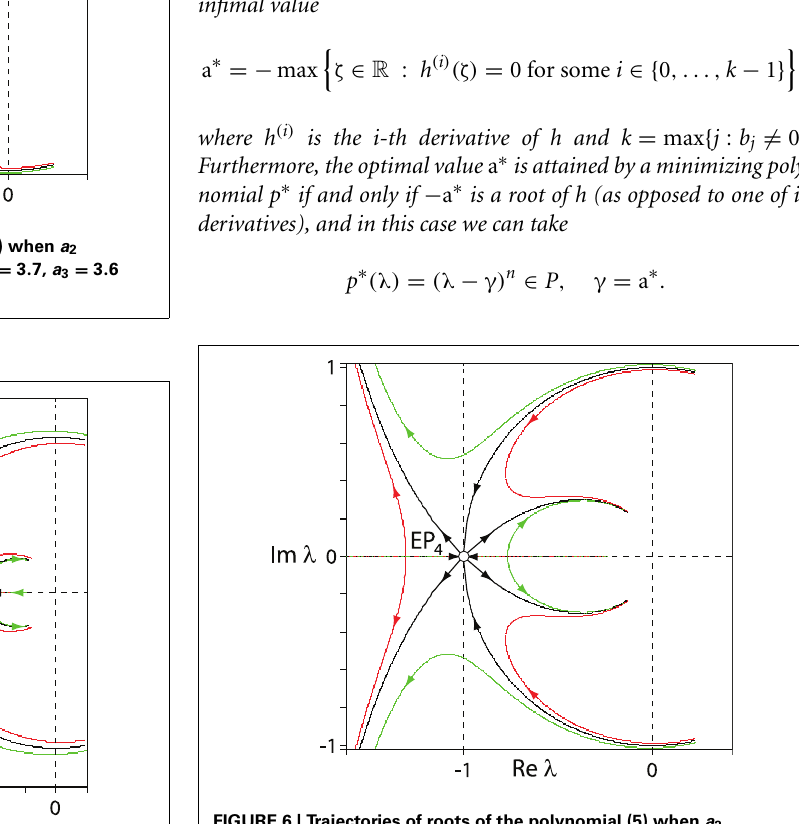
FIGURE 6 | Trajectories of roots of the polynomial (5) when a 2 increases from 0 to 15 and: a 1 = a 3 = 4 (black); a 1 = 4, a 3 = 3 . 9 (red); a 1 = 3 . 9, a 3 = 4 (green). The global minimum of the abscissa is attained when all the roots coalesce into the quadruple root λ = − 1 (EP 4 ). 7 As explained in [27], most of this result when F = R was established by R. Chen in a 1979 Ph.D.